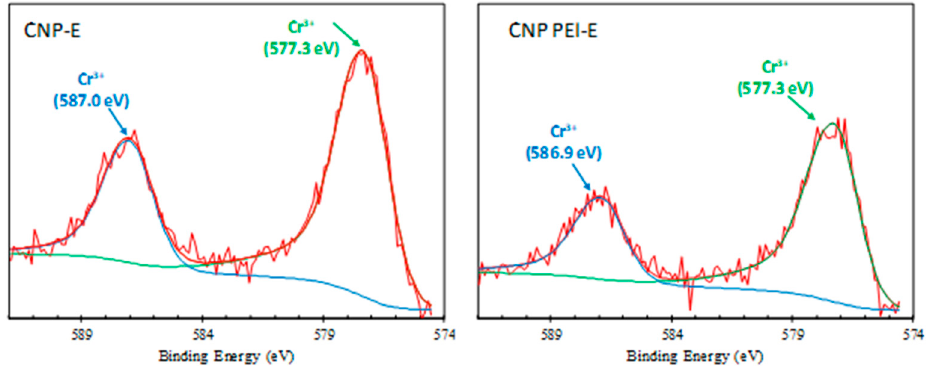
Figure 7. Cr 2p XPS spectra of CNP-E and CNP PEI-E.